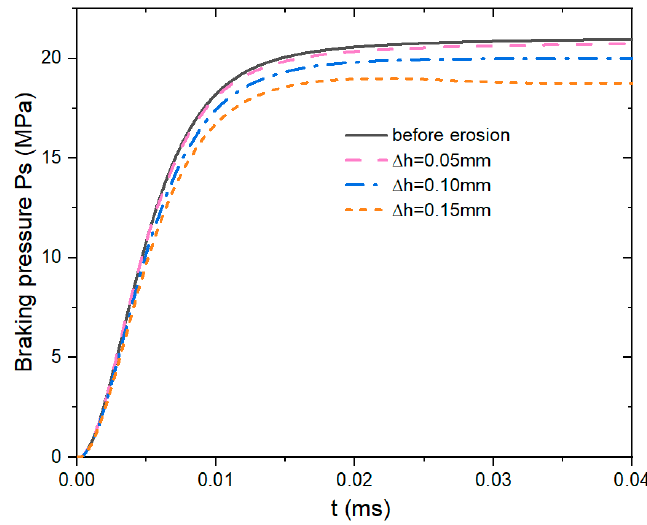
Figure 17. Brake pressures before and after erosion.